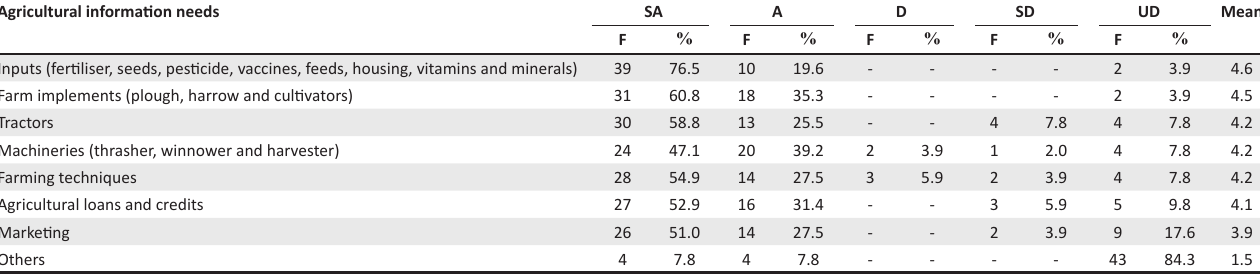
TABLE 5: Opinions of the heads of branch libraries on agricultural information needs of rural dwellers ( N = 51). Agricultural information needs